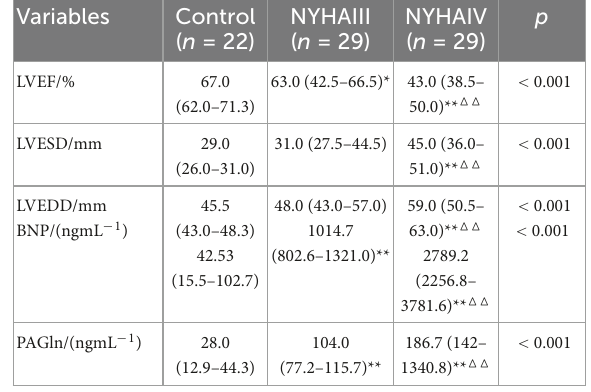
TABLE 2 Comparison of the echocardiographic indicators, brain natriuretic peptide (BNP), and phenylacetylglutamine (PAGln) levels between Control, New York Heart Association (NYHA) class III, and NYHA class IV.